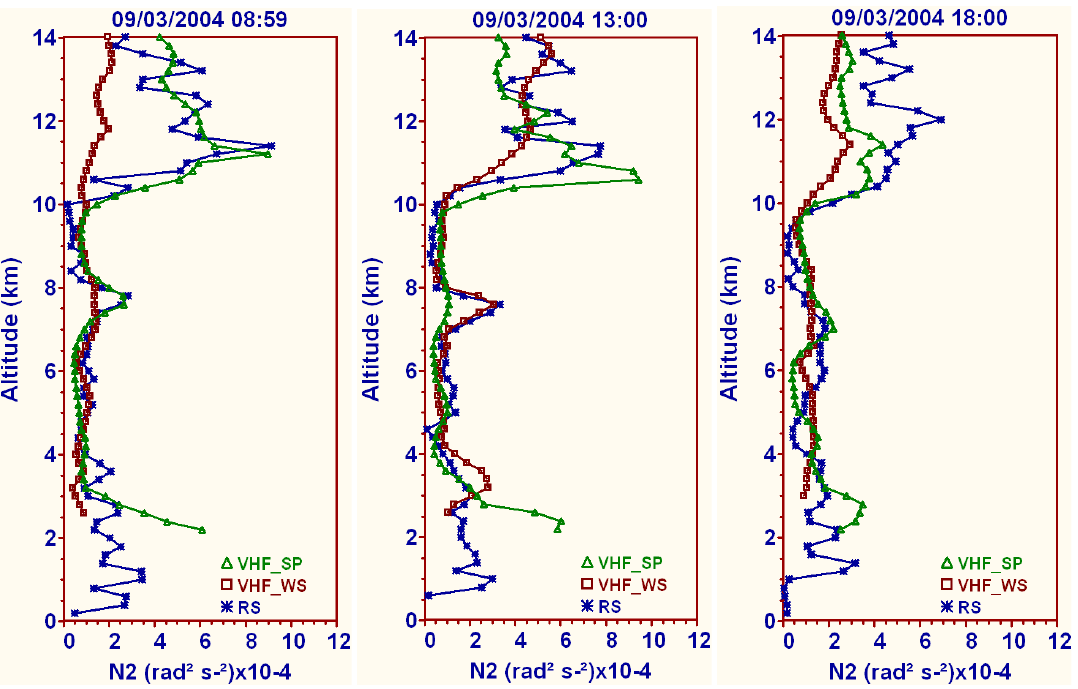
Fig. 4. Comparison of N 2 between radio soundings (RS) and VHF radar (VHF) using respectively the signal power (VHF SP) and the vertical wind spectrum (VHF WS)